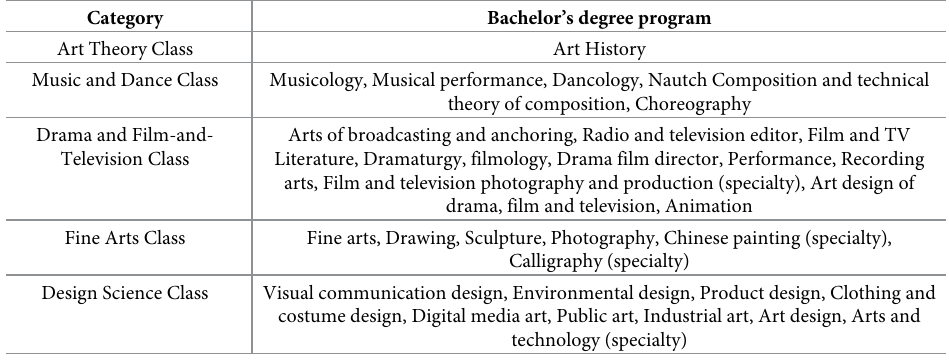
Table 1. Art studies category major